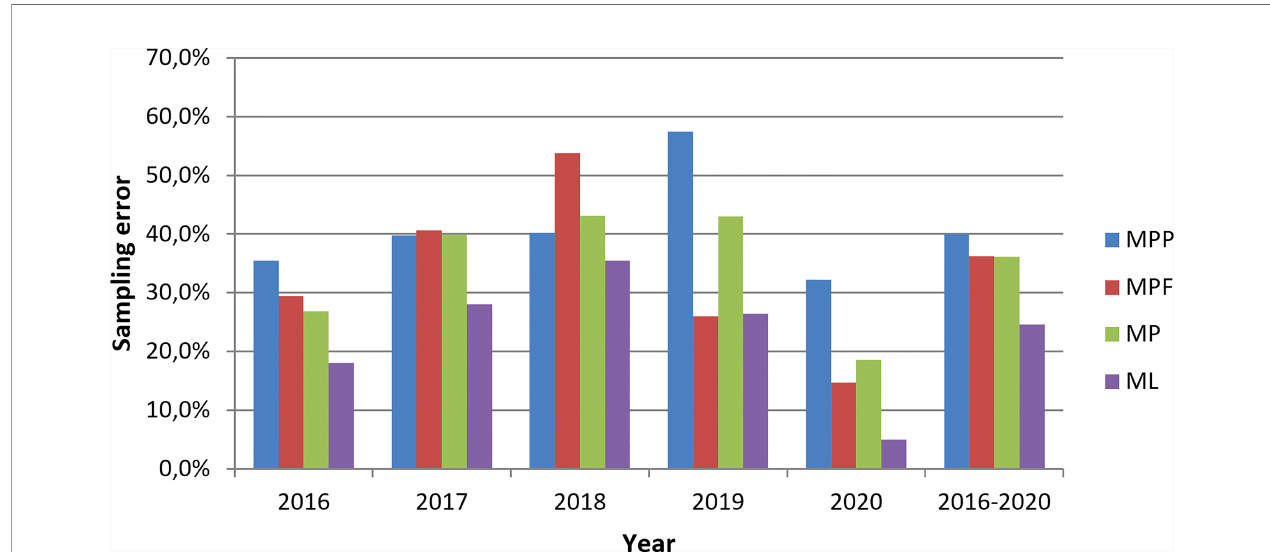
FIGURE 2 | Yearly spatiotemporal sampling error estimated from TalTech data during 2016 – 2020 for ML (microlitter), MP (microplastics), MPF (microplastic fi ber) and MPP (non- fi ber microplastic)